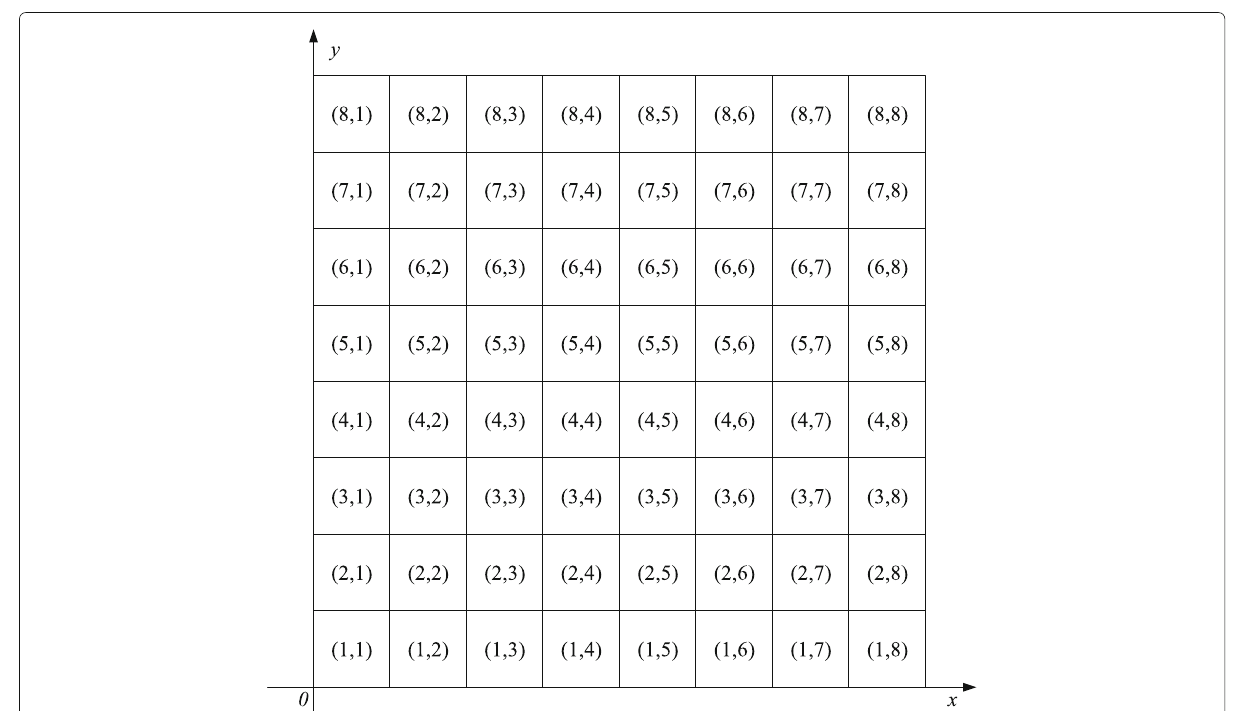
Fig. 3 The RCN of virtual grid cell. It shows the RCS of virtual grid cell